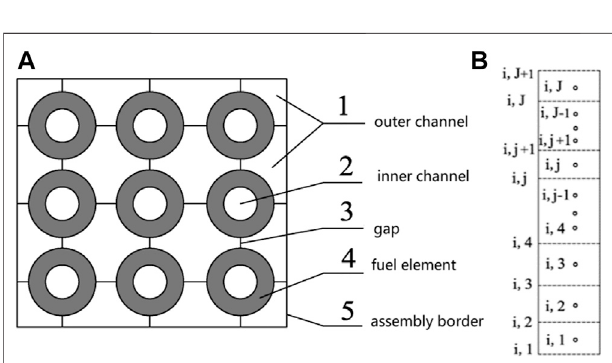
FIGURE 2 | Division and numbering of sub-channel (A) and axial section (B)